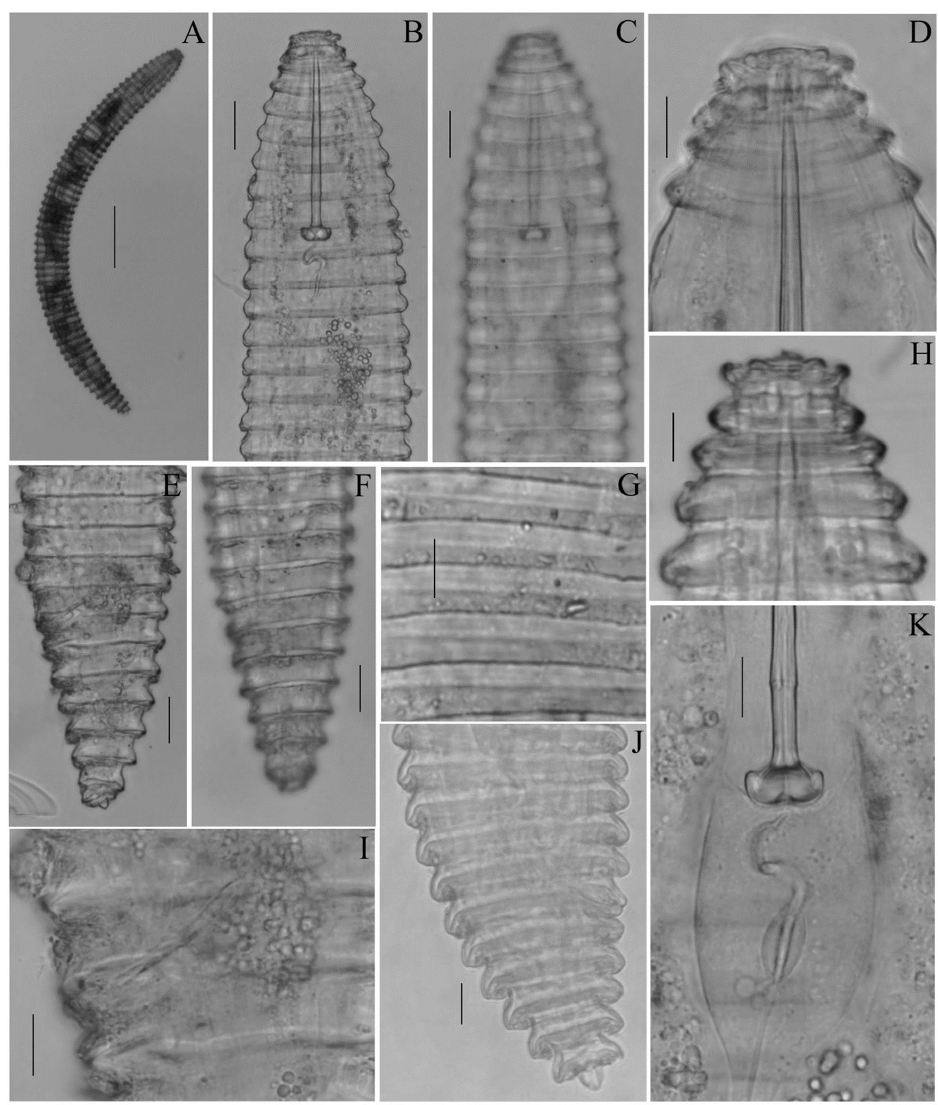
Figure 4. Diagnostic characters in the females of Criconemoides informis . (A): Total body; (B,C): detail of the anterior end stylet and pharyngeal region; (D,H): head with sub-median lobes; (E,F,I,J): pos- terior end, vulva, and tail region; (G): surface margins; and (K): pharyngal region. (Scale bars: ( A – C , E , F ) = 100 µm; ( D , G , K ) = 20 µm).